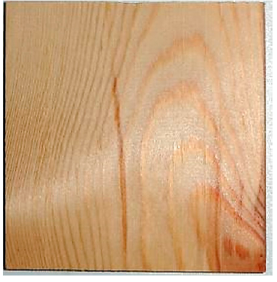
Figure 5. Photo of softwood sample pine tangential cut.